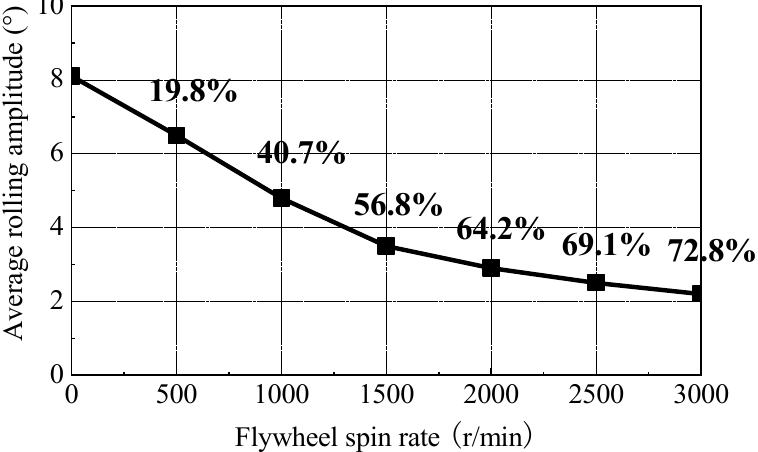
Figure 10. Average roll amplitude of the ship and average anti-roll rate for varying flywheel spin rates.